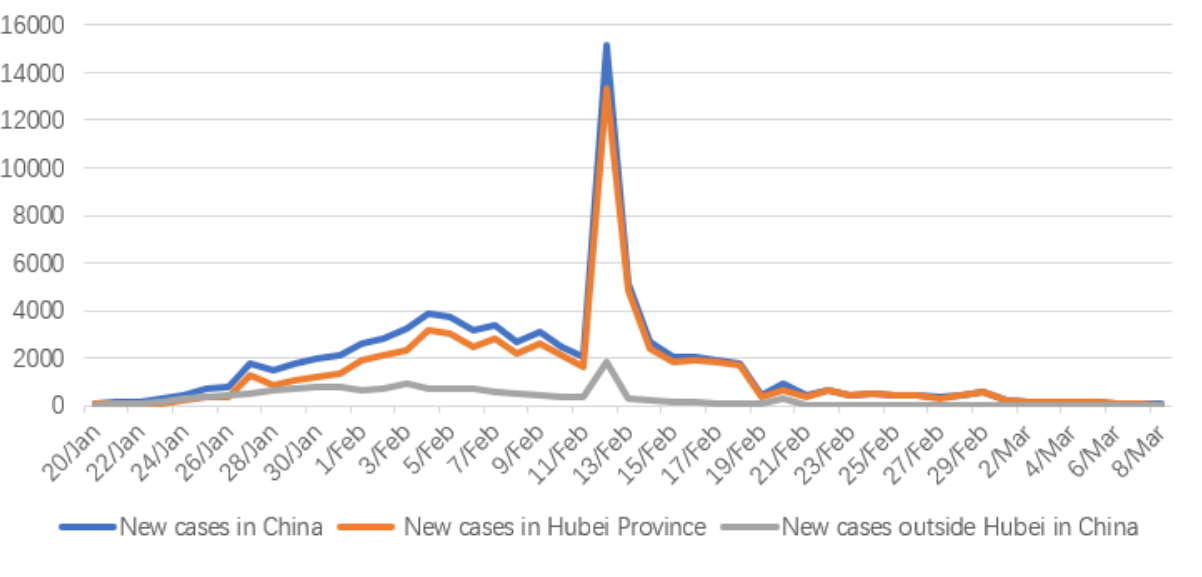
Figure 1. Daily new cases of coronavirus disease (COVID-19) in China since January 20,